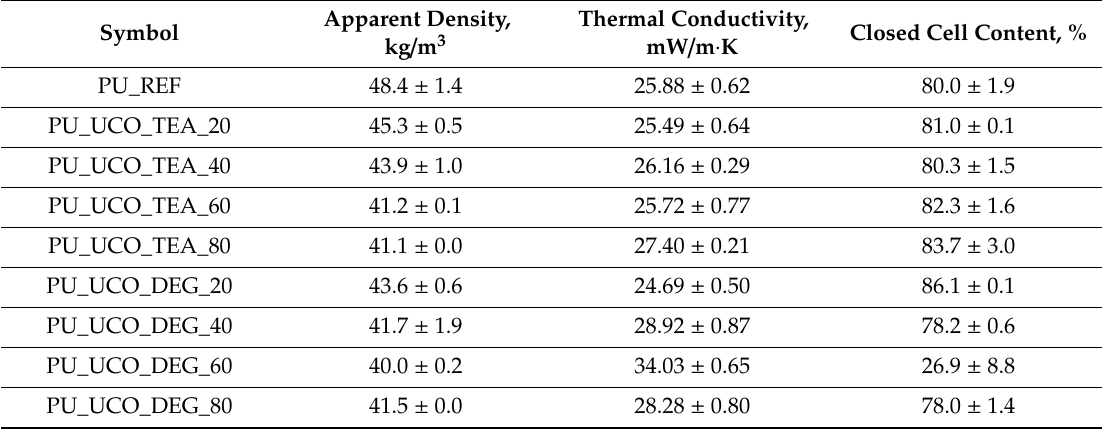
Table 4. Apparent density, heat conduction coe ffi cient and closed cell content of foam materials containing di ff erent amounts of UCO_TEA and